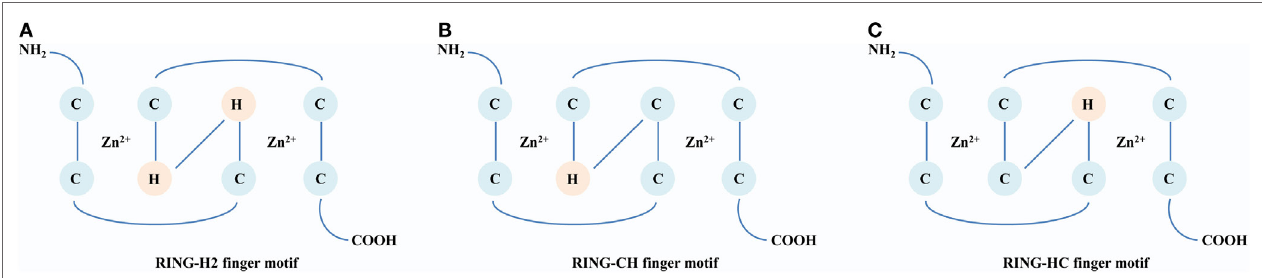
FiGURe 1 | A comparison of structures of the RING domain. Conserved Zn 2 + -binding ligands are shown in circles [cysteine (C) and histidine (H)]. (A) RING-H2 finger motif. The histidine residues are in both the fourth and fifth positions within the motif. (B) RING-CH finger motif. The cysteine and histidine residues are in the fourth and fifth positions, respectively, within the motif. (C) RING-HC finger motif: The histidine and cysteine residues are in the fourth and fifth positions, respectively, within the motif.